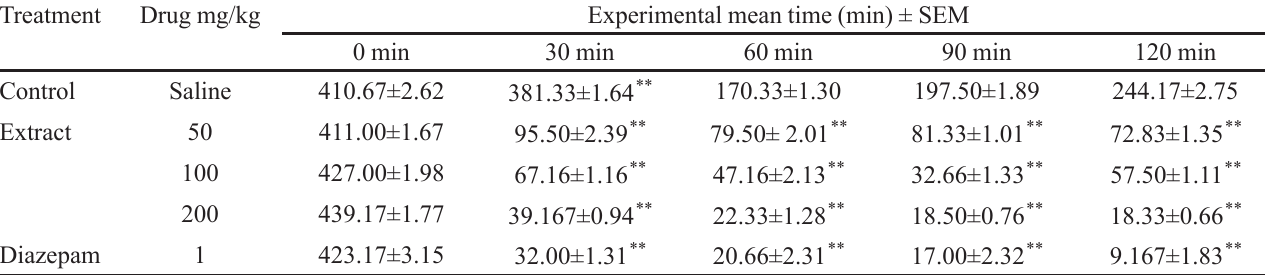
TABLE I - Effect of PO extract on spontaneous motor activity